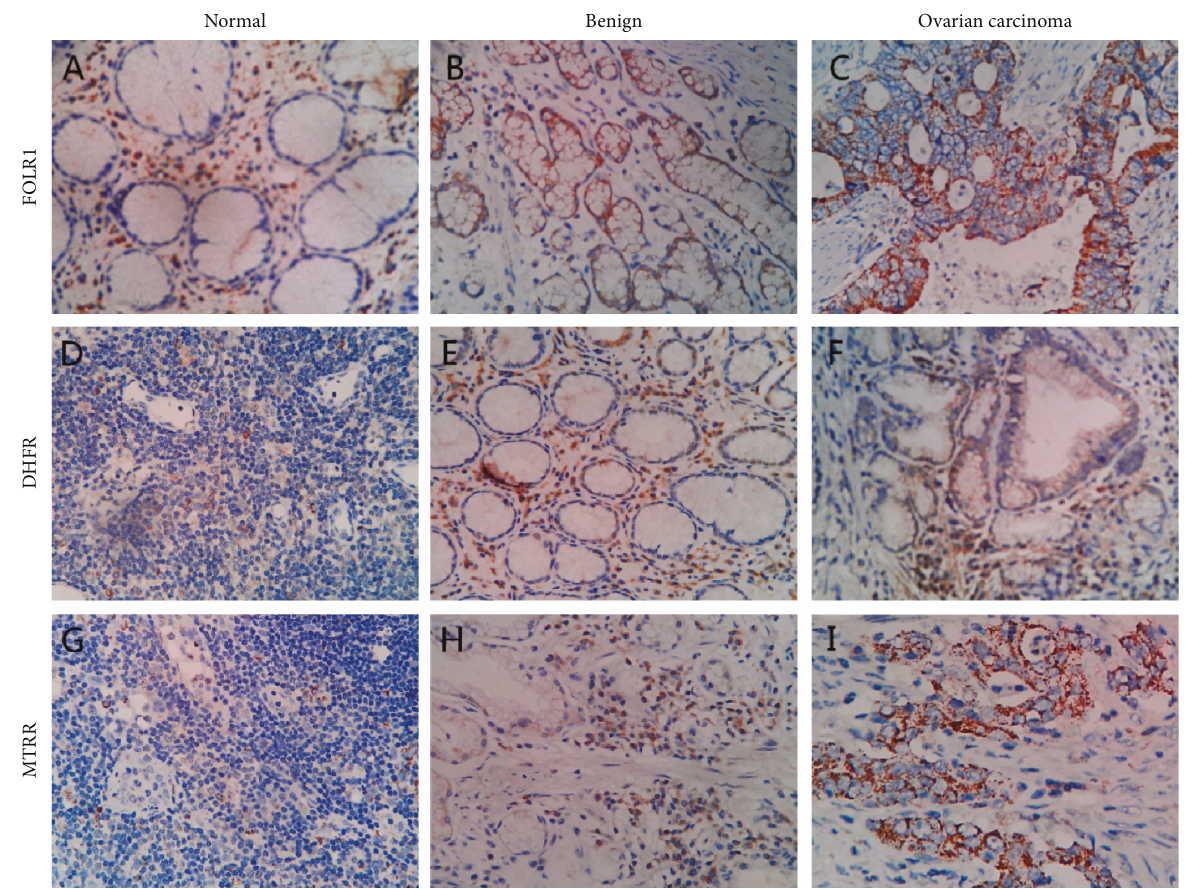
Figure 2: Immunohistochemical results of FOLR, DHFR, and MTRR in di ff erent ovarian tissues. (a – c) FOLR1 expression in di ff erent ovarian tissues. (d – f) DHFR expression in di ff erent ovarian tissues. (g – i) MTRR expression in di ff erent ovarian tissues (original magni fi cation, Table 1: FOLR1, DHFR, and MTRR expression in di ff erent tissues.